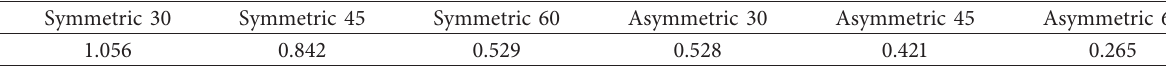
Table 4: Strain rate concentration factor at different notch opening angles.